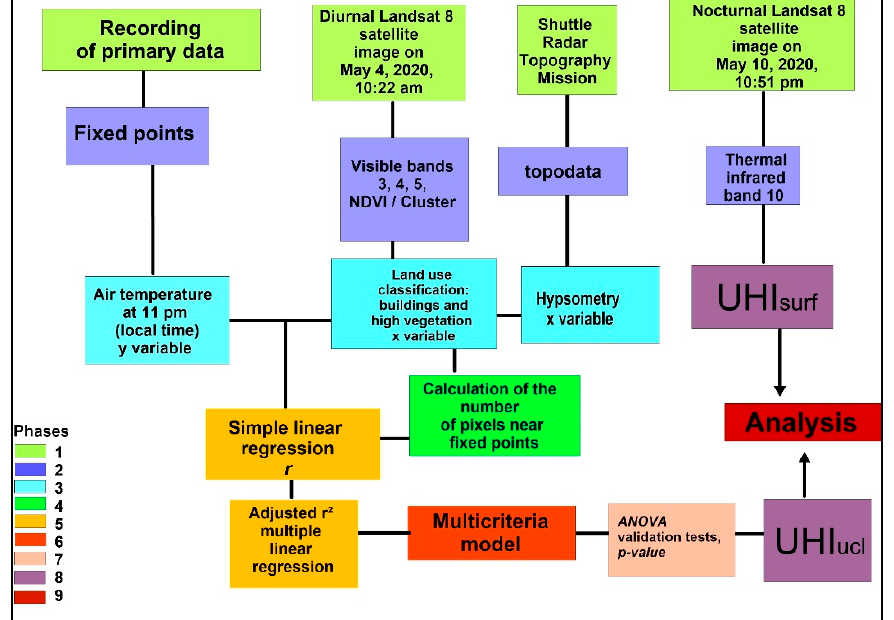
Scheme 1. Data processing phases. Elaborated by the authors